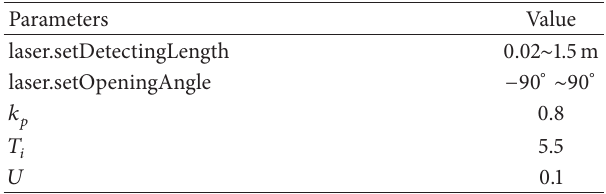
Table 3: The value of the experiment